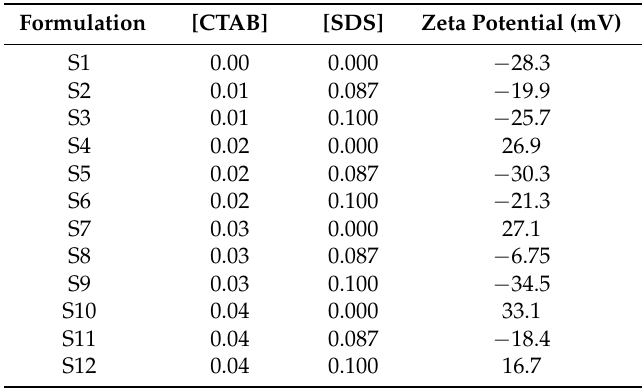
Table 2. Zeta potential data collated from all CuNPs